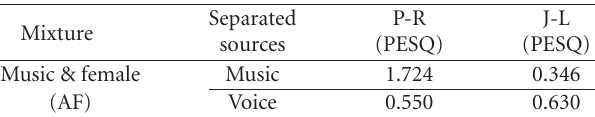
Table 2: PESQ for two di ff erent methods: P-R (our proposed ap- proach) and J-L [35]. The mixture comprises a female voice with musical background (rock